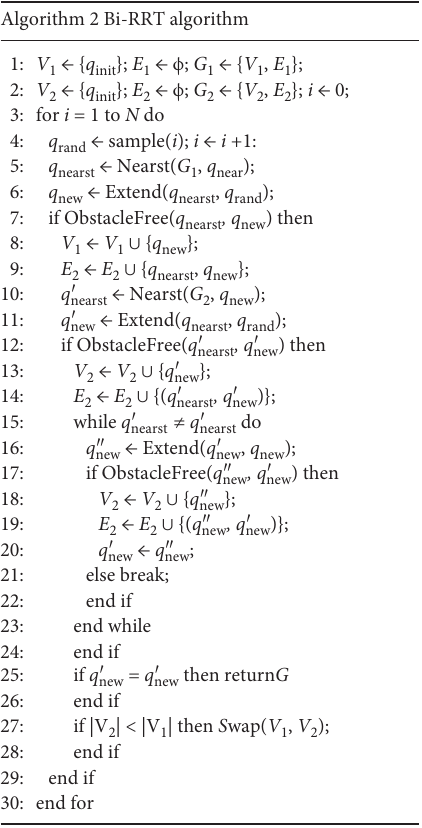
Figure 4: Basic Bi-RRT